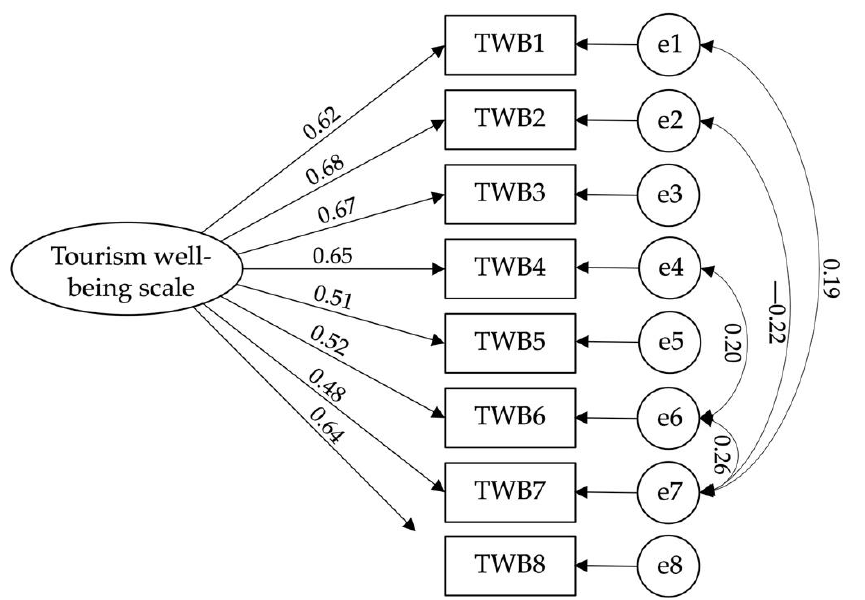
Figure 5. Model fit of Tourism Wellbeing Scale.